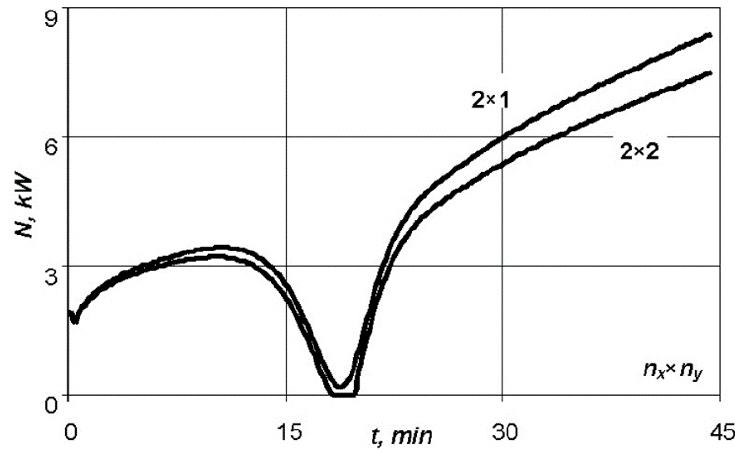
Figure 8. Graph of dependence of the power consumption on time for various numbers of aluminium stiffening ribs.